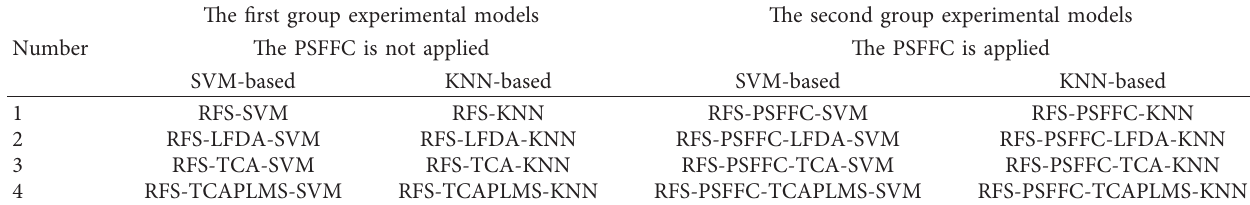
Table 4: Fault diagnosis models.